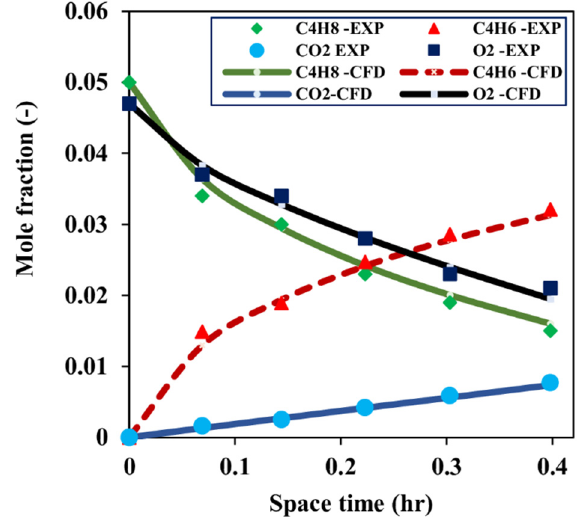
Figure 5. Comparison of the CFD simulation results with experimental data in terms of mole fractions (EXP: experiment).